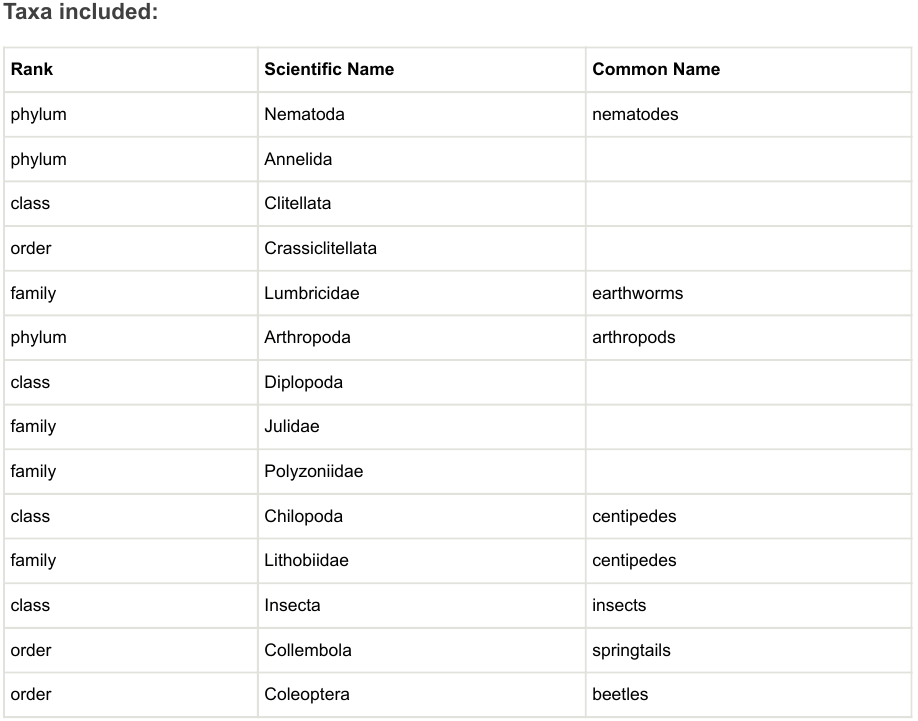
Figure 5. The number of macrofauna species in pine forests along the pollution